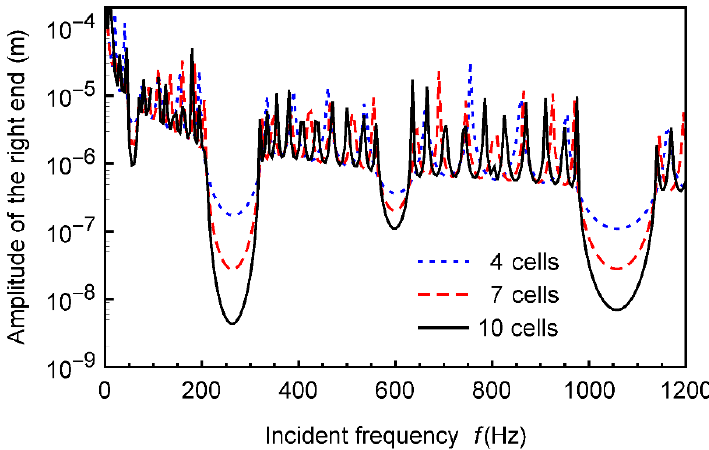
Figure 7. Frequency responses of the fluid-conveying periodic pipe with different numbers of cells.